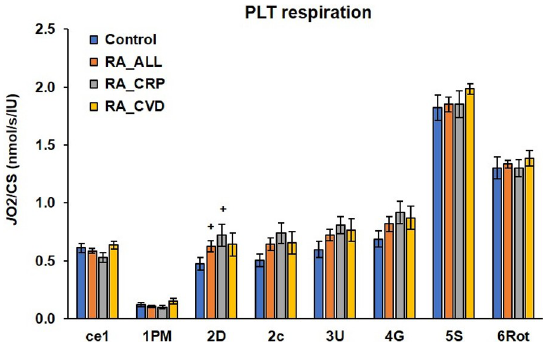
Fig 2. Platelet mitochondrial function in control subjects and groups of RA patients. The parameters of mitochondrial respiration in human platelets expressed as oxygen (O 2 ) flux per mitochondrial marker–the activity of citrate synthase (CS). The bars show mean ± sem. The names on x-axis represent steps in the SUIT protocol RP1 (see the legend for Fig 1). Control = control subjects; RA_ALL = all patients with rheumatoid arthritis; RA_CRP = rheumatic patients with high c-reactive protein concentration; RA_CVD = rheumatic patients with cardiovascular diseases; + p < 0.1.